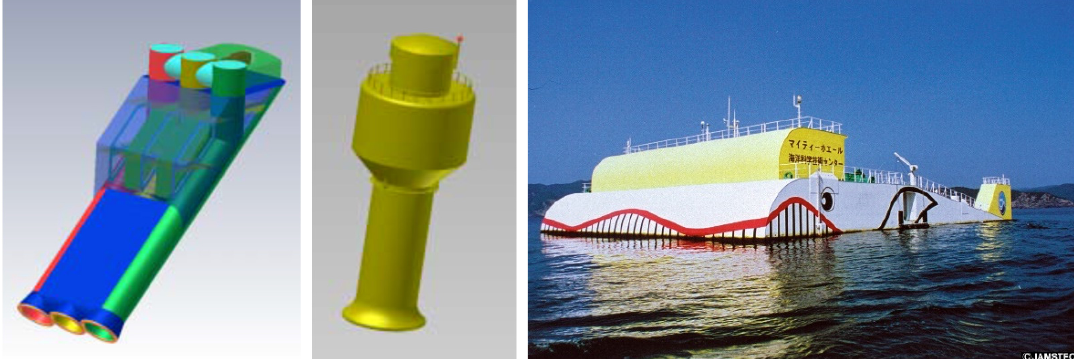
Figure 17. Sloped Buoy ( left ) [61], Spar Buoy ( middle ) [61] and Mighty Whale ( right ) [64].